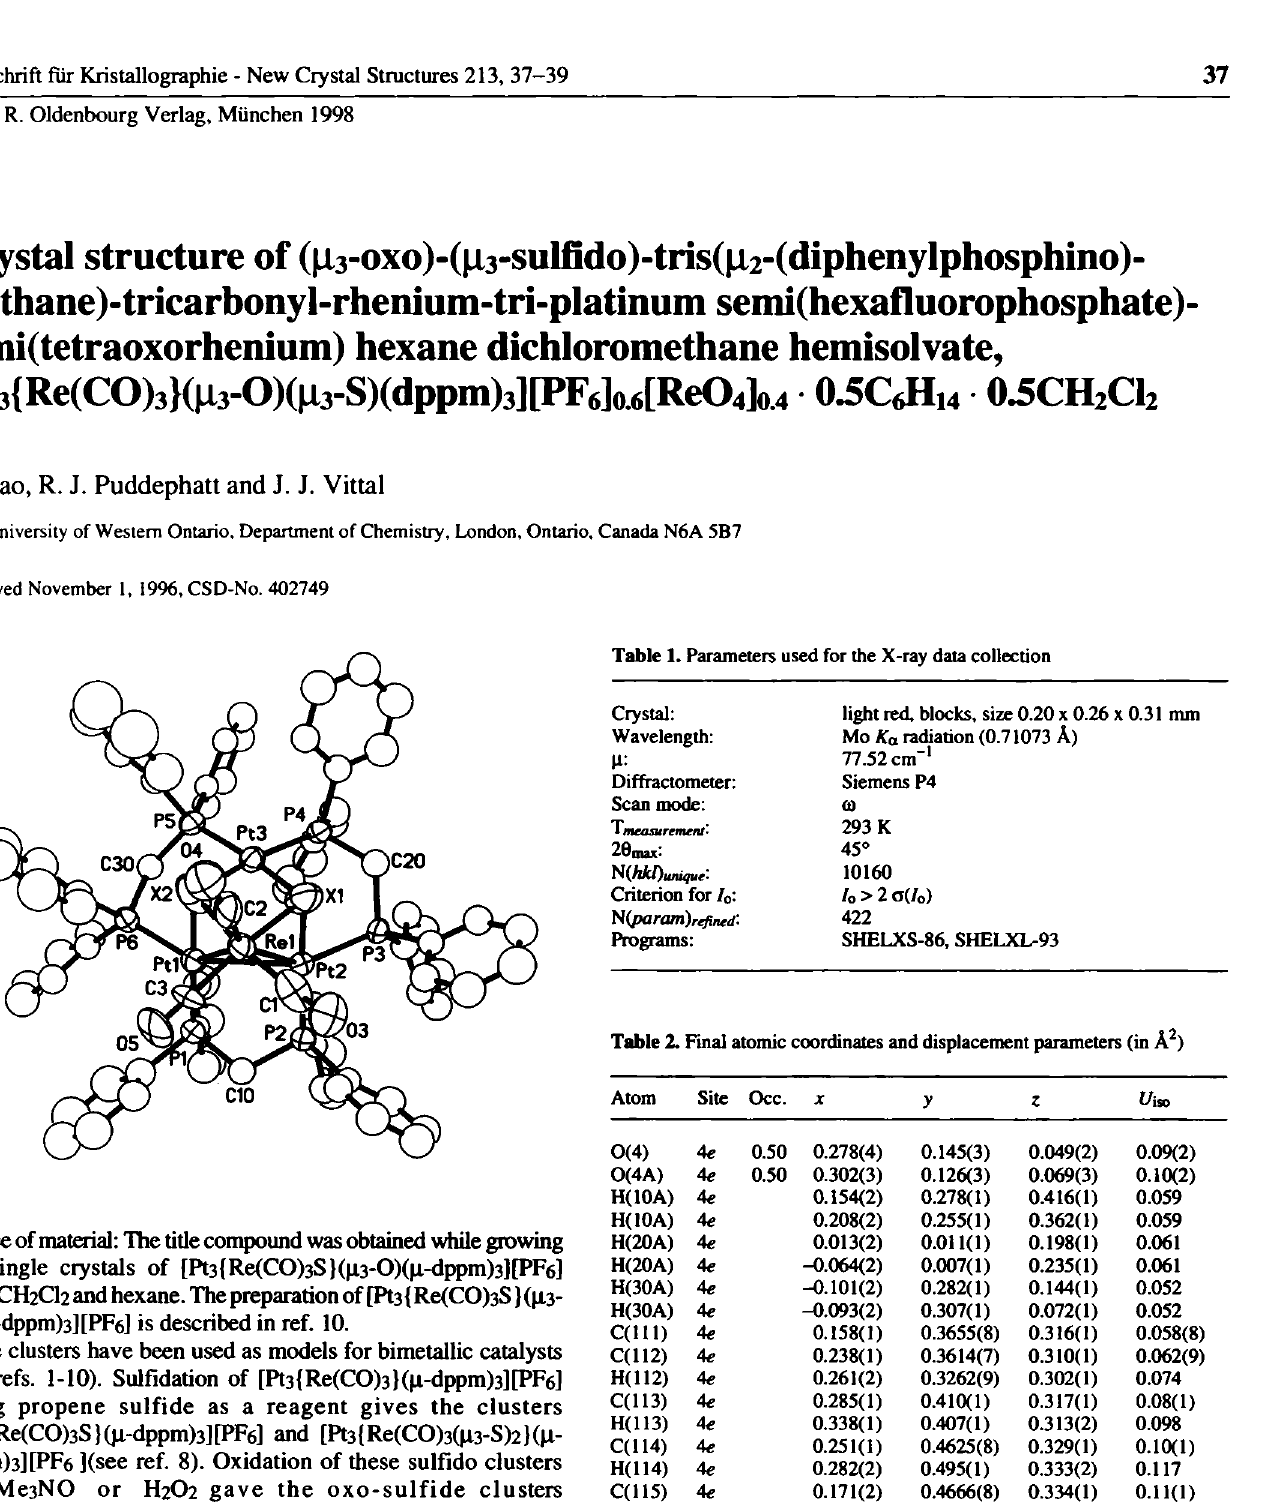
Table 2. Final atomic coordinates and displacement parameters (in